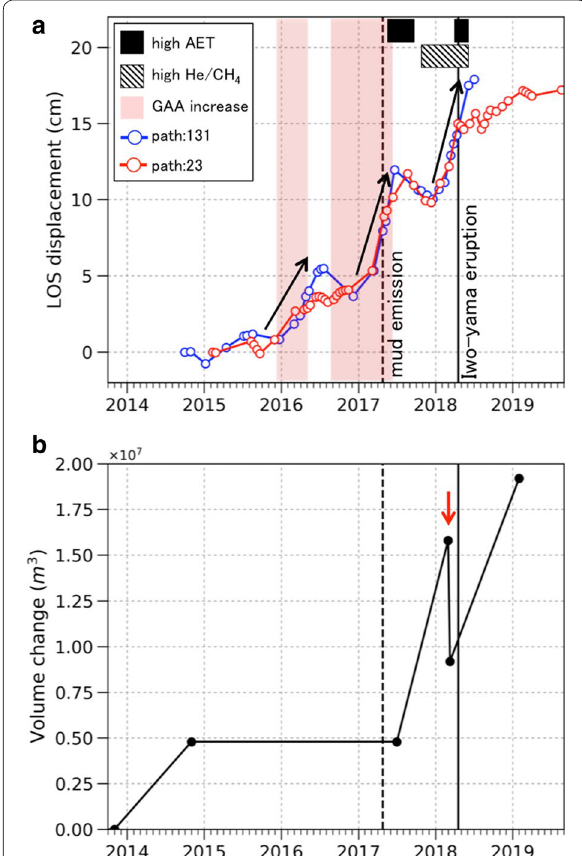
Fig. 9 Comparison between the dLOS time series and other observations (thermal, volcanic gas, and GNSS observation). a Co-plot of the dLOS time series, He/CH 4 ratio of fumarole gases, apparent equilibrium temperature (AET) of fumarole gases, and GAA. The striped rectangle indicates the time period when relatively larger values of He/CH 4 ratio (> 1.0) were observed by Tokai Univ. et al. (2018). The black rectangles indicate time periods at which relatively larger AET values (> 400 °C) were observed by Tokai Univ. et al. (2018). The pink-shaded zones indicate time periods at which GAA increases were observed by Tajima et al. (2020). The red and blue circles indicate dLOS time series of path 131 and 23 at peak B (same as in Fig. 8). b Plot of cumulative volume change of the magma chamber at 7-km depth after November 2013, derived from GNSS baseline observation (JMA 2019). The red arrow indicates the timing of the Shinmoe-dake eruption with co-eruptive deflation of the magma